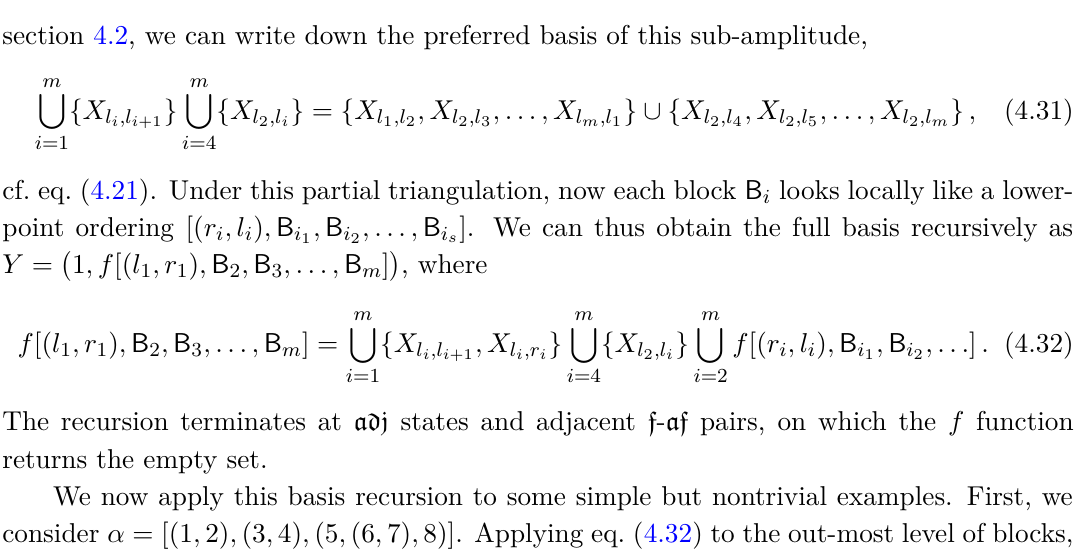
Figure 9 . An example of the preferred basis Y for α = [(1 , 2) , (3 , 4) , (5 , (6 , (7 , 8) , 9) , 10)] . The blue and red lines collectively correspond to the chosen basis. While the blue lines correspond to the partial triangulation which yields sub-polygons associated with purely adj sub-amplitudes, the red lines correspond to the triangulations of the remaining